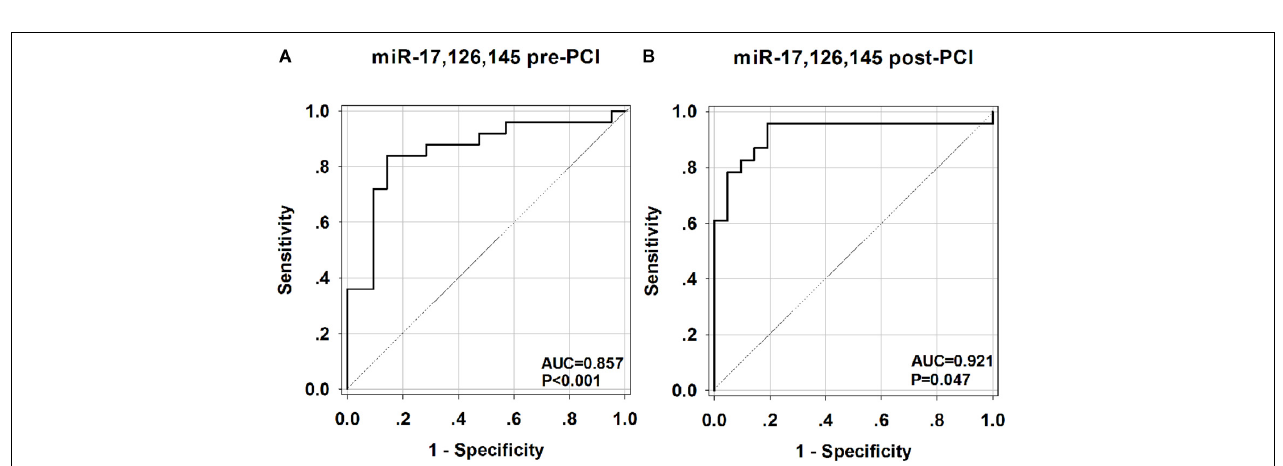
FIGURE 6 | Receiver operating characteristic (ROC) curves analysis of the combination of miR-17-5p, miR-126-5p, miR-145-3p for predicting AMI. The areas under the curves (AUC) are 0.857 (95% CI: 0.743–0.971, p < 0.001) for the combination of miR-17-5p, miR-126-5p, miR-145-3p before PCI (A) and 0.921 (95% CI: 0.829–1.014, p = 0.047) for the combination of miR-17-5p, miR-126-5p, miR-145-3p after PCI (B) . CI, confidence interval.